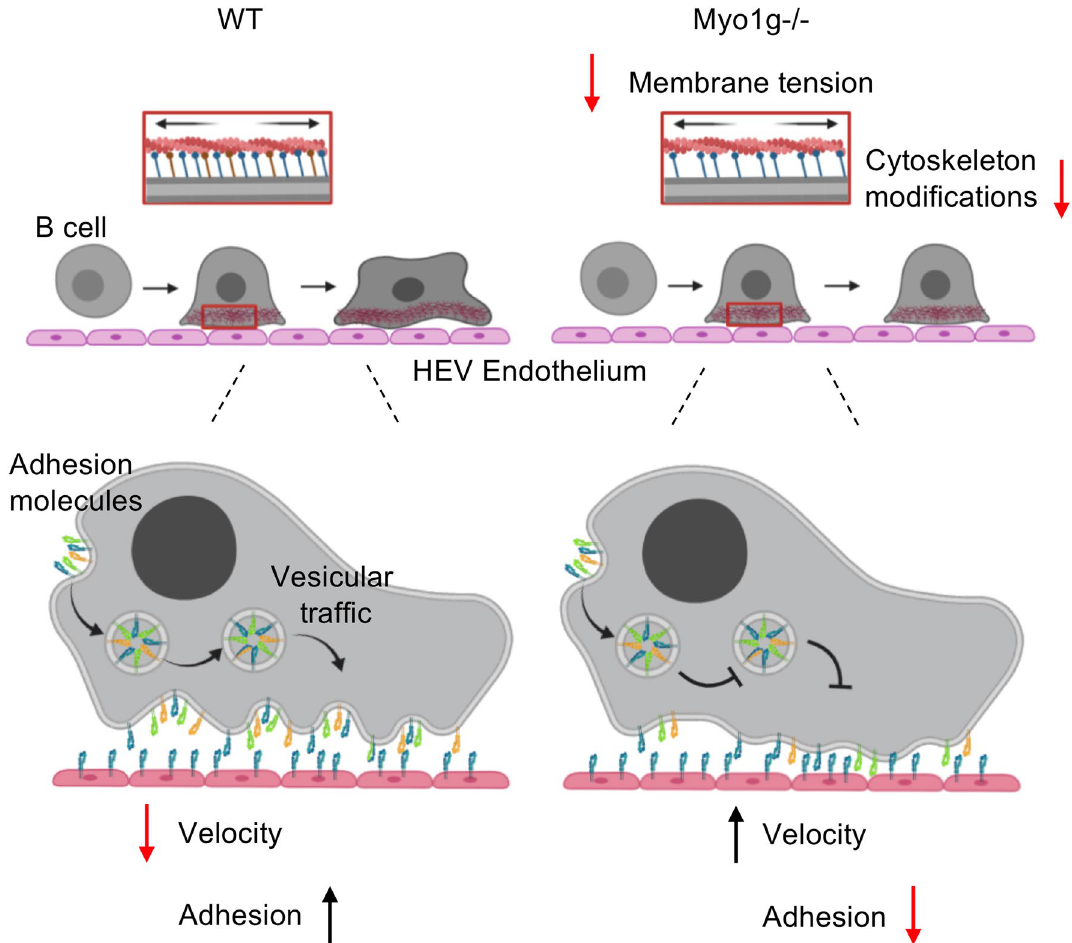
Figure 6. The absence of Myo1g limits the ability of B lymphocytes to generate morphological changes during migration. Schematic illustration of the role of Myo1g during activated B lymphocytes migration. In absence of Myo1g activated B lymphocytes have a lower capacity to exert changes in their morphology and lower surface expression of adhesion molecules. These changes increase their speed of movement, reducing the interaction between the B lymphocyte and the endothelium, directly affecting homing of B lymphocytes towards the inguinal lymph node. Created with